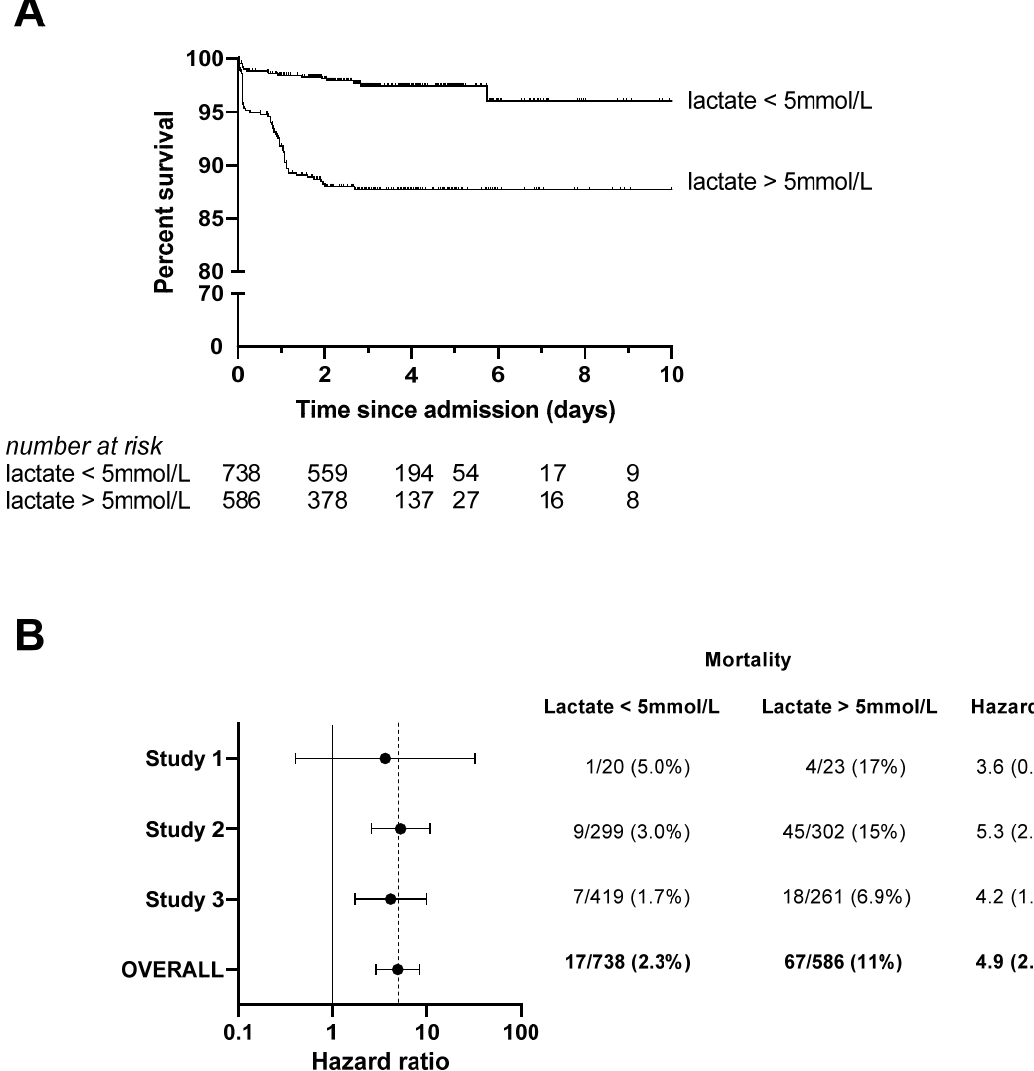
9.0%, and 3.7%, respectively, and the pooled mortality was 84/1324 (6.3%). There were 67 deaths (11%) among children with hyperlactatemia at admission and 17 deaths (2.3%) among children with normal lactate ( p < 0.0001). Hyperlactatemia was associated with a crude HR of mortality of 5.3 (95%CI 3.1–9.0, p < 0.0001, Figure 1A). After adjustment for age, sex, clinical severity score (fixed effects), study, and site (random effects), the adjusted HR (aHR) was 3.0 (95%CI 1.8–5.3, p < 0.0001, Table 2). In the subgroup of 690 patients with parasitemia confirmed by microscopy, the aHR was 4.0 (95%CI 1.7–9.2, p < 0.0001). Subgroup analysis by study is shown in Figure 1B.